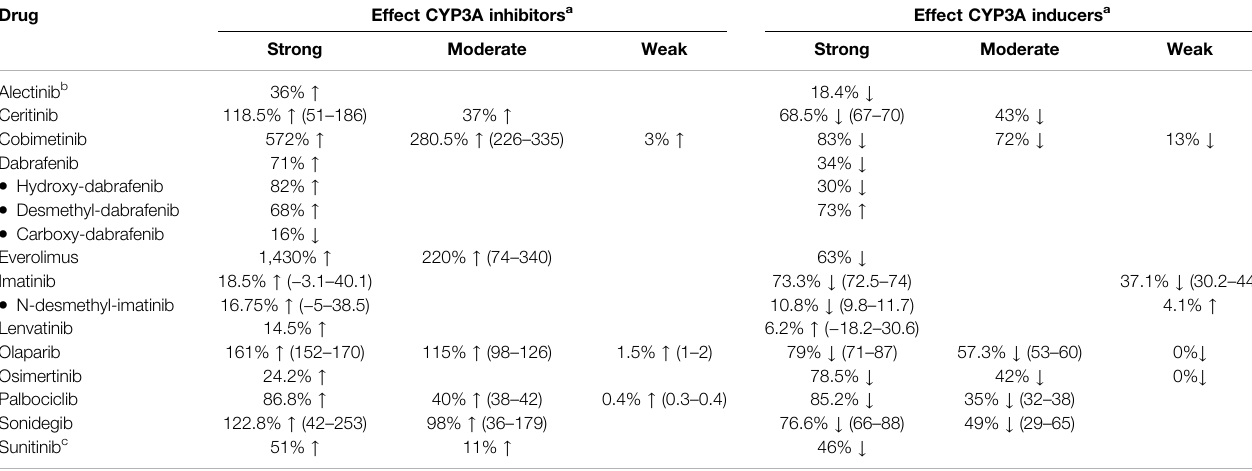
TABLE 1 | Summary table of the results of DDI studies performed with the reviewed oral oncolytic drugs.